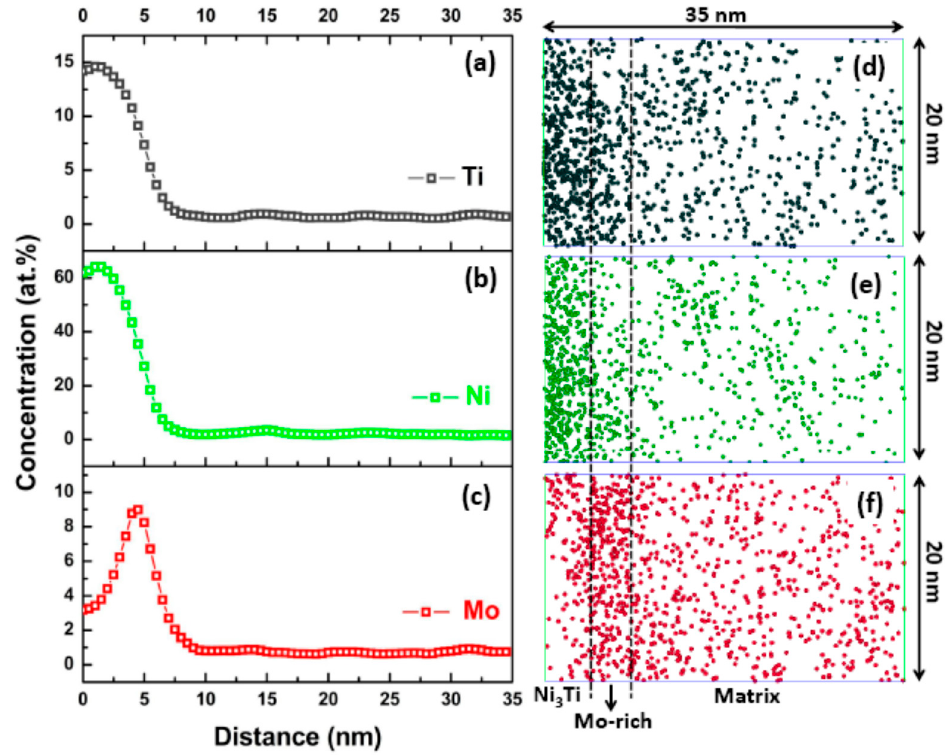
Figure 4. 1-D reconstruction of the atomic positions ( d – f ), and the corresponding one-dimensional concentration profile ( a – c ), across the Ni 3 Ti/matrix interface for peak-aged specimen.